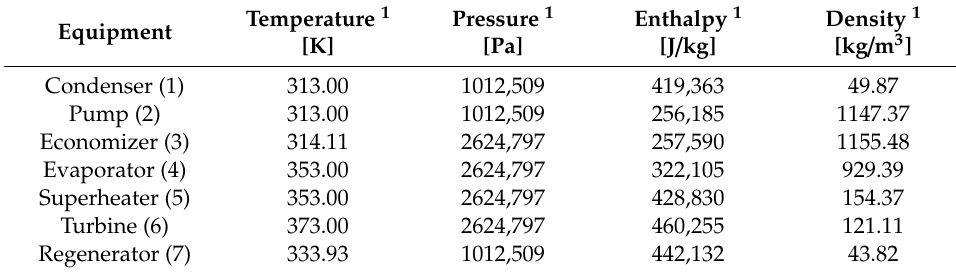
Table 3. R134a thermodynamic parameters.